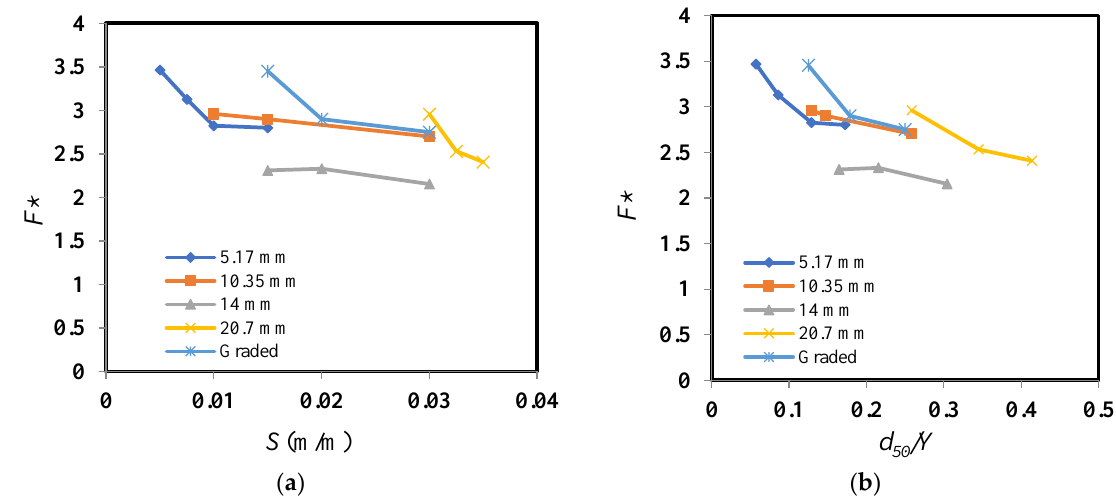
Figure 9. Particle Froude number as a function of bed slope ( a ) and relative roughness ( b ) for uniform and graded bed sediment.